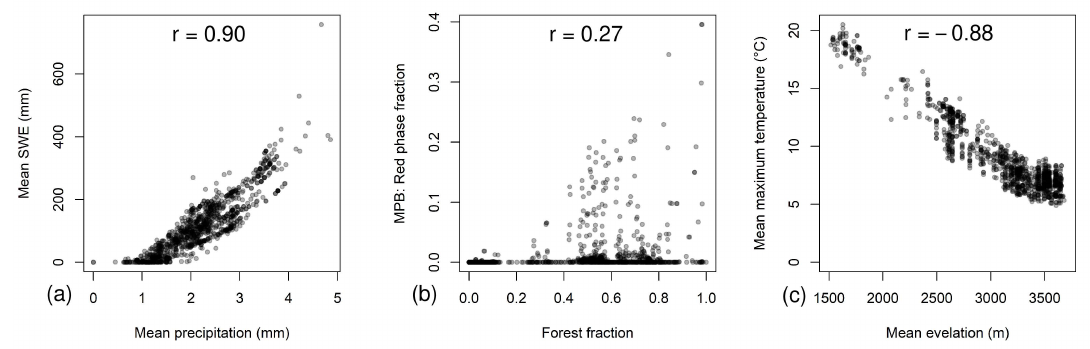
Figure 3. Pairwise comparison of potential predictor values for the 1174 DOC data points and their associated Pearson correlation: ( a ) yearly mean monthly precipitation and yearly mean monthly SWE; ( b ) forest fraction and MPB-Red phase fraction; and ( c ) mean elevation and yearly mean monthly maximum